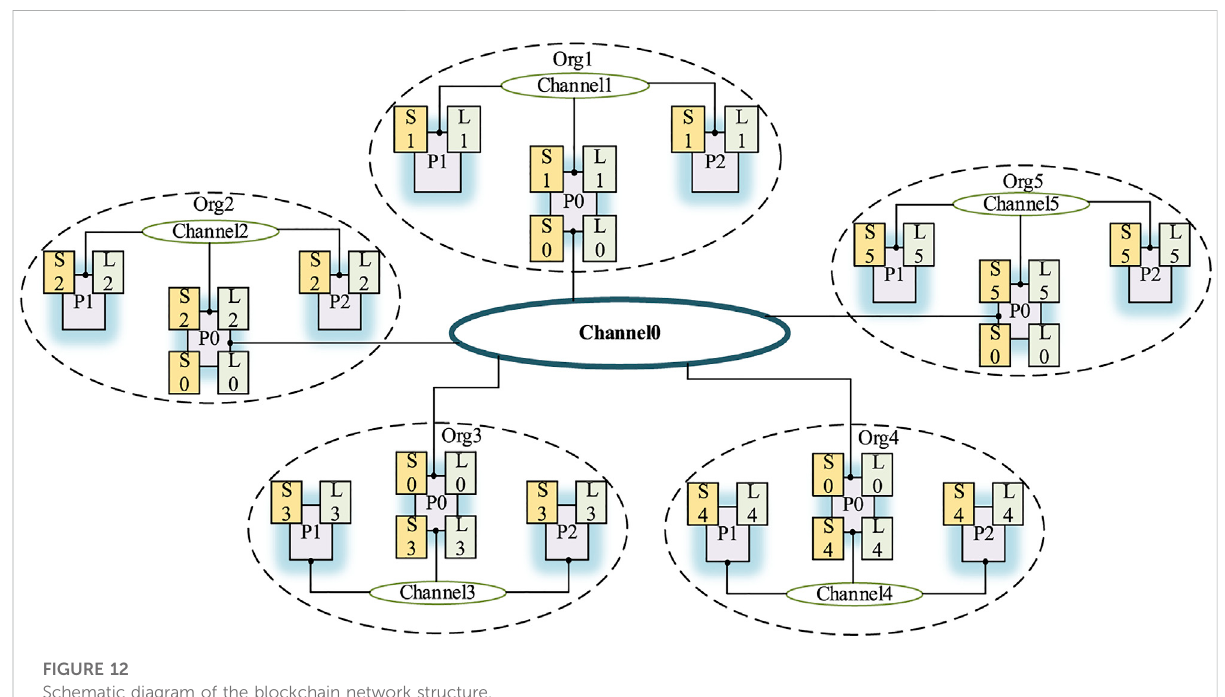
FIGURE 12 Schematic diagram of the blockchain network structure.